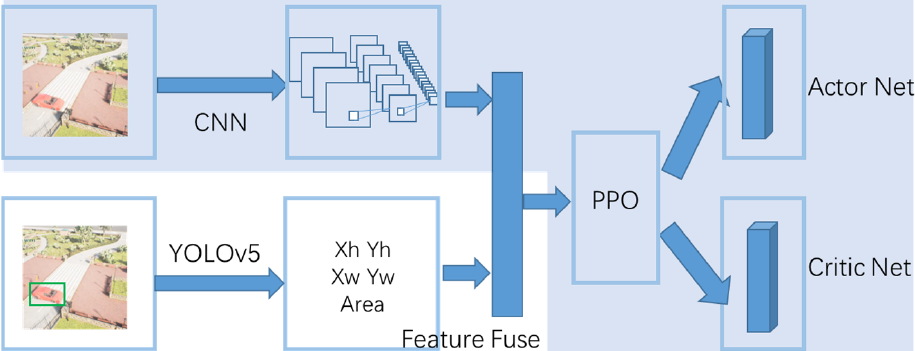
Figure 6. FF-PPO architecture. The input of the PPO algorithm contains two parts: One is the image acquired by the UAV, and the other part is the location information of the target acquired by the YOLOv5 algorithm. X h , Y h , X w , Y w represent the position of the object, and area denotes the area of the target identified by the YOLO algorithm in the